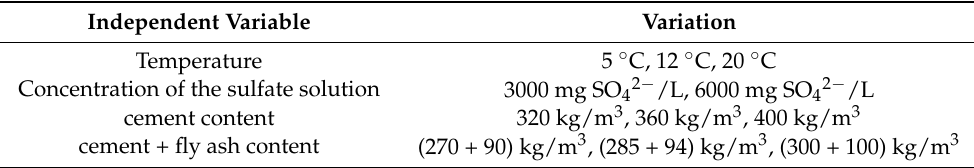
Table 4. Examined independent